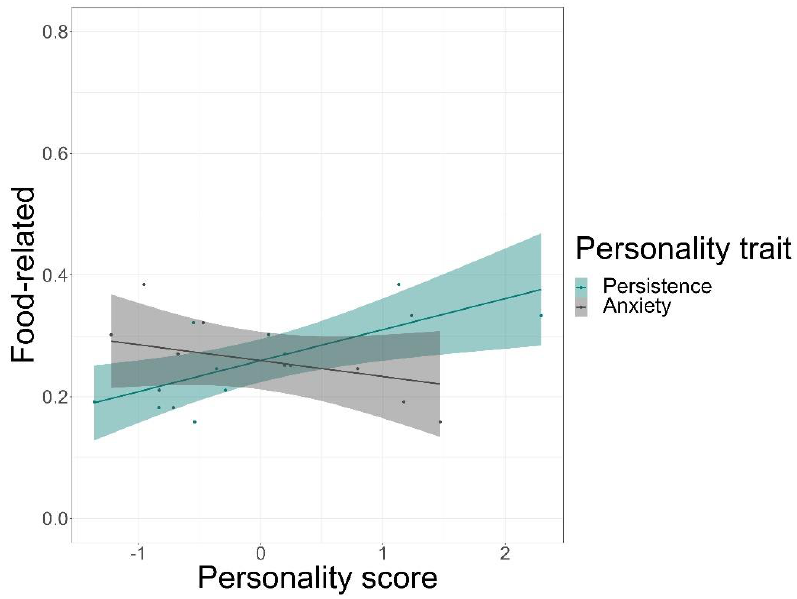
Figure 3. Time spent on food-related behaviours in percentages and its relation to the personality scores of the traits of persistence and anxiety. The solid line is a trend line surrounded by the 95% confidence interval.